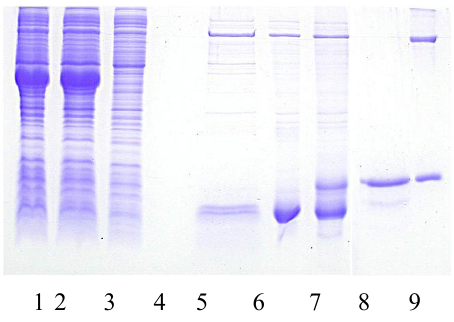
FIGURE 3. SDS-PAGE gel (15% w/v) of samples from the production of semisynthetic RNase A: 1, crude cell extract; 2, soluble fraction; 3, chitin column flow through; 4, chitin column wash, 5, eluted RNase A(1–94); 6, concentrated sample #5; 7, ligation reaction; 8, purified ligation product, namely semisynthetic RNase A; 9, molecular weight marker: BSA (67 kDa), RNase A (13.8